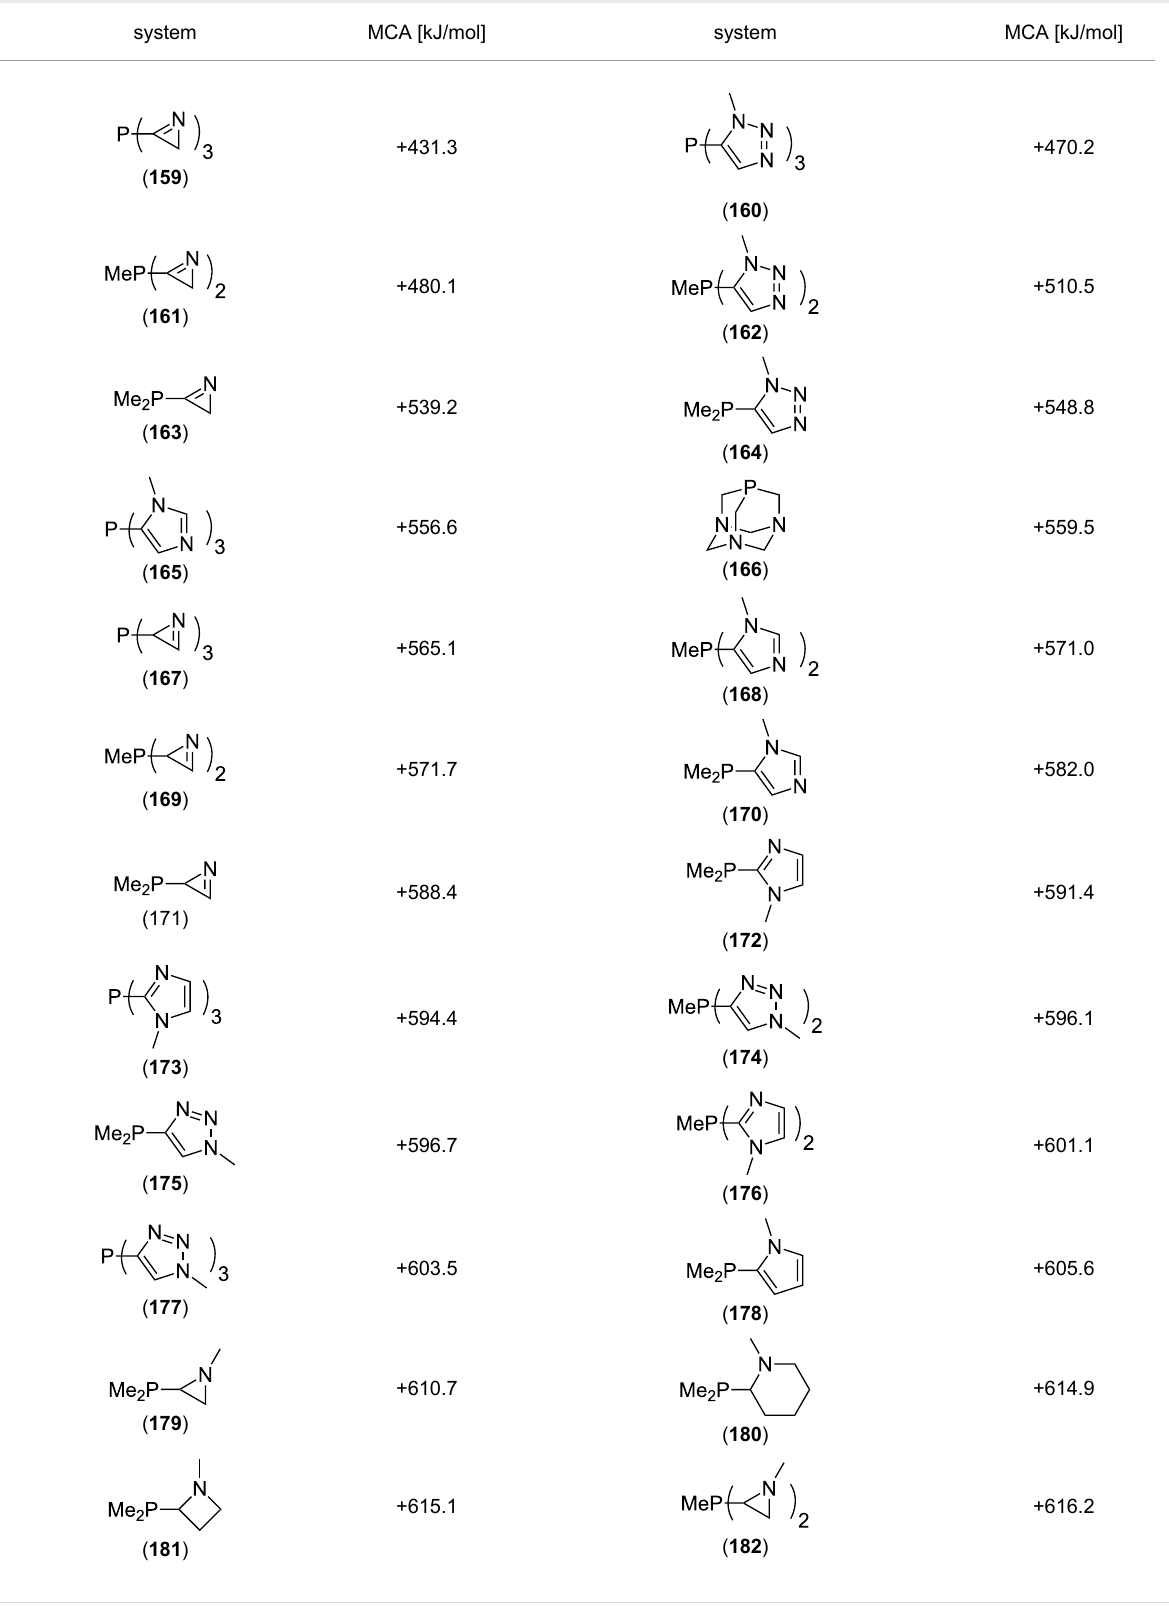
Table 4: MCA values of phosphanes with nitrogen-containing substituents lacking direct phosphorous–nitrogen